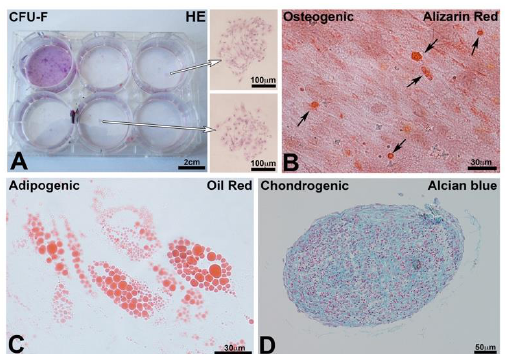
Figure 2. ( A ) Colony forming unit fibroblasts test (CFU-F): staining with HE of CFU formed after 14 days in culture. Arrows indicate 2 colonies. ( B ) Osteogenic differentiation after 21 days in the osteogenic medium; the differentiated cells produced nodules of mineralization stained with Alizarin Red S (arrows). ( C ) Adipocyte differentiation after 21 days in an adipogenic medium. Differentiated cells produced lipid vacuoles stained with Oil Red O. ( D ) Chondrocyte differentiation of the micromasses of hBM-MSCs after 21 days. Alcian Blue visualized the glycosaminoglycans (GAGs) specifically present in the cartilage.